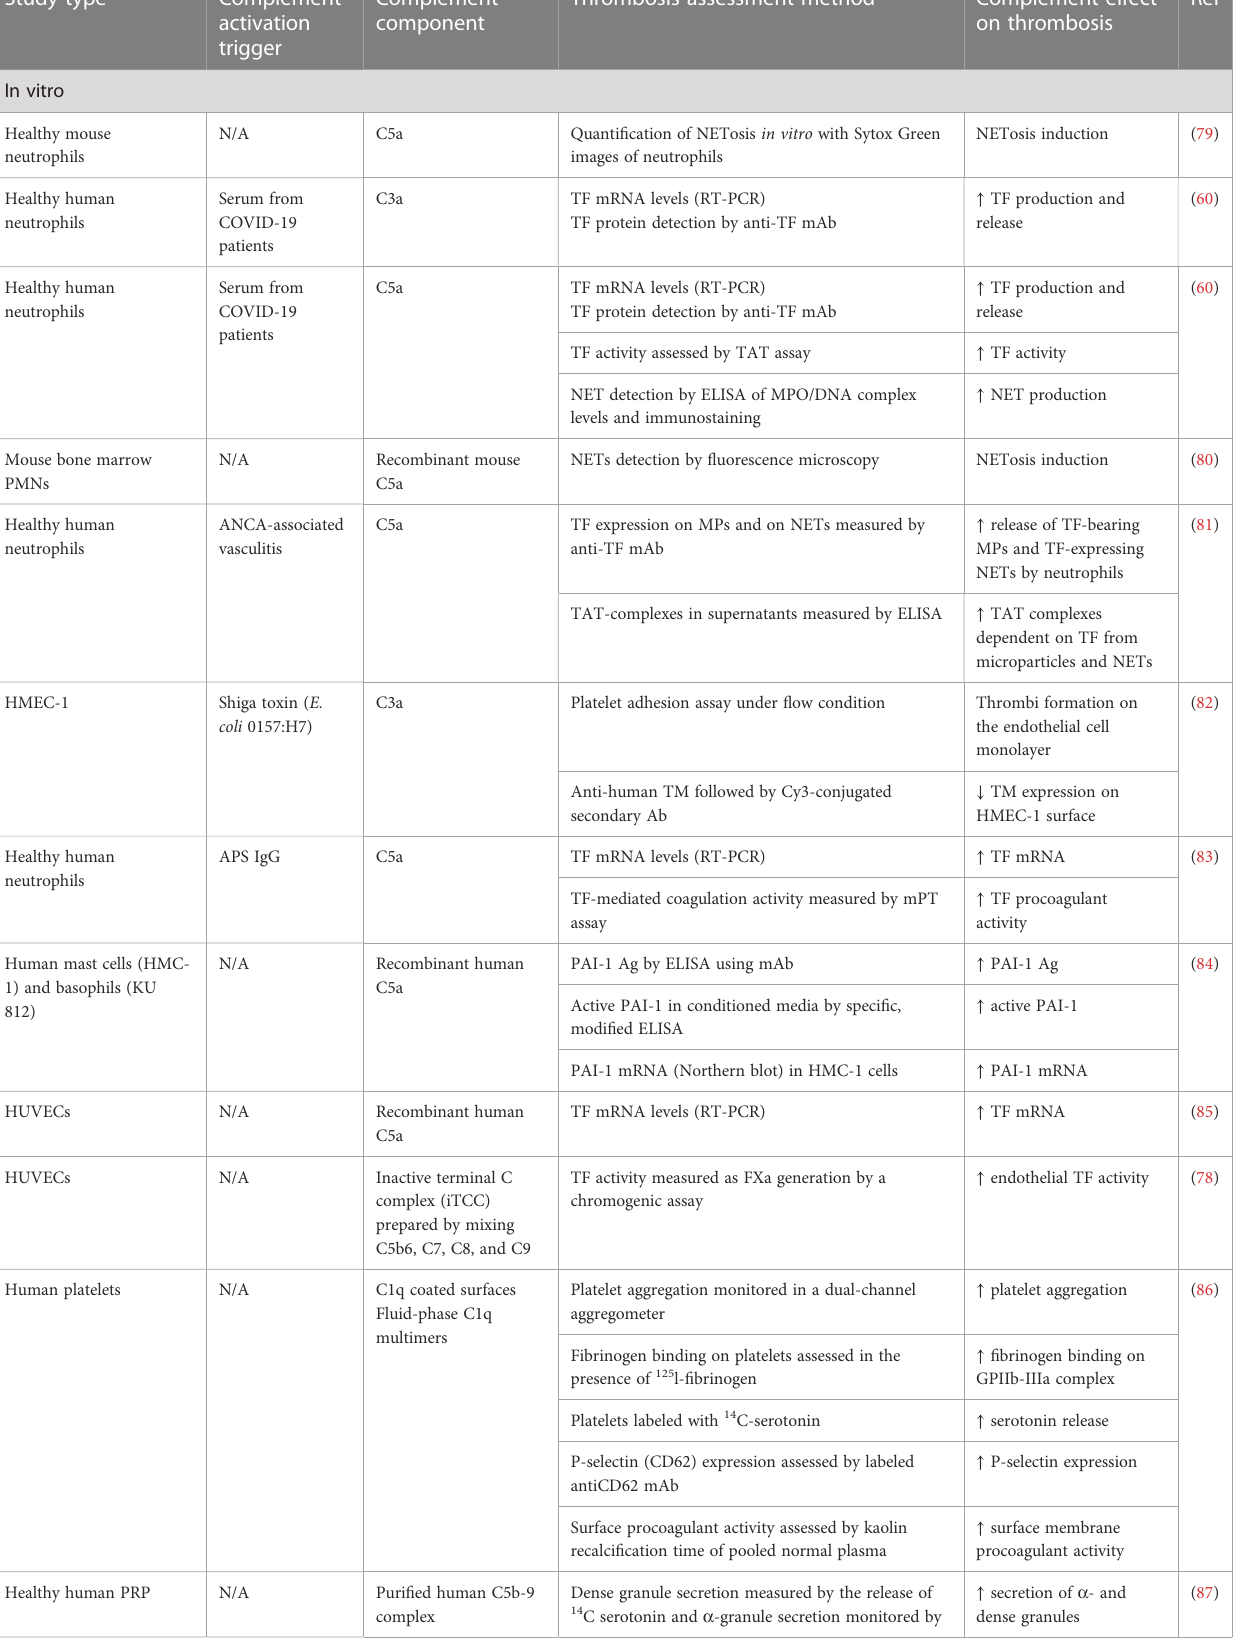
TABLE 2 Complement role in